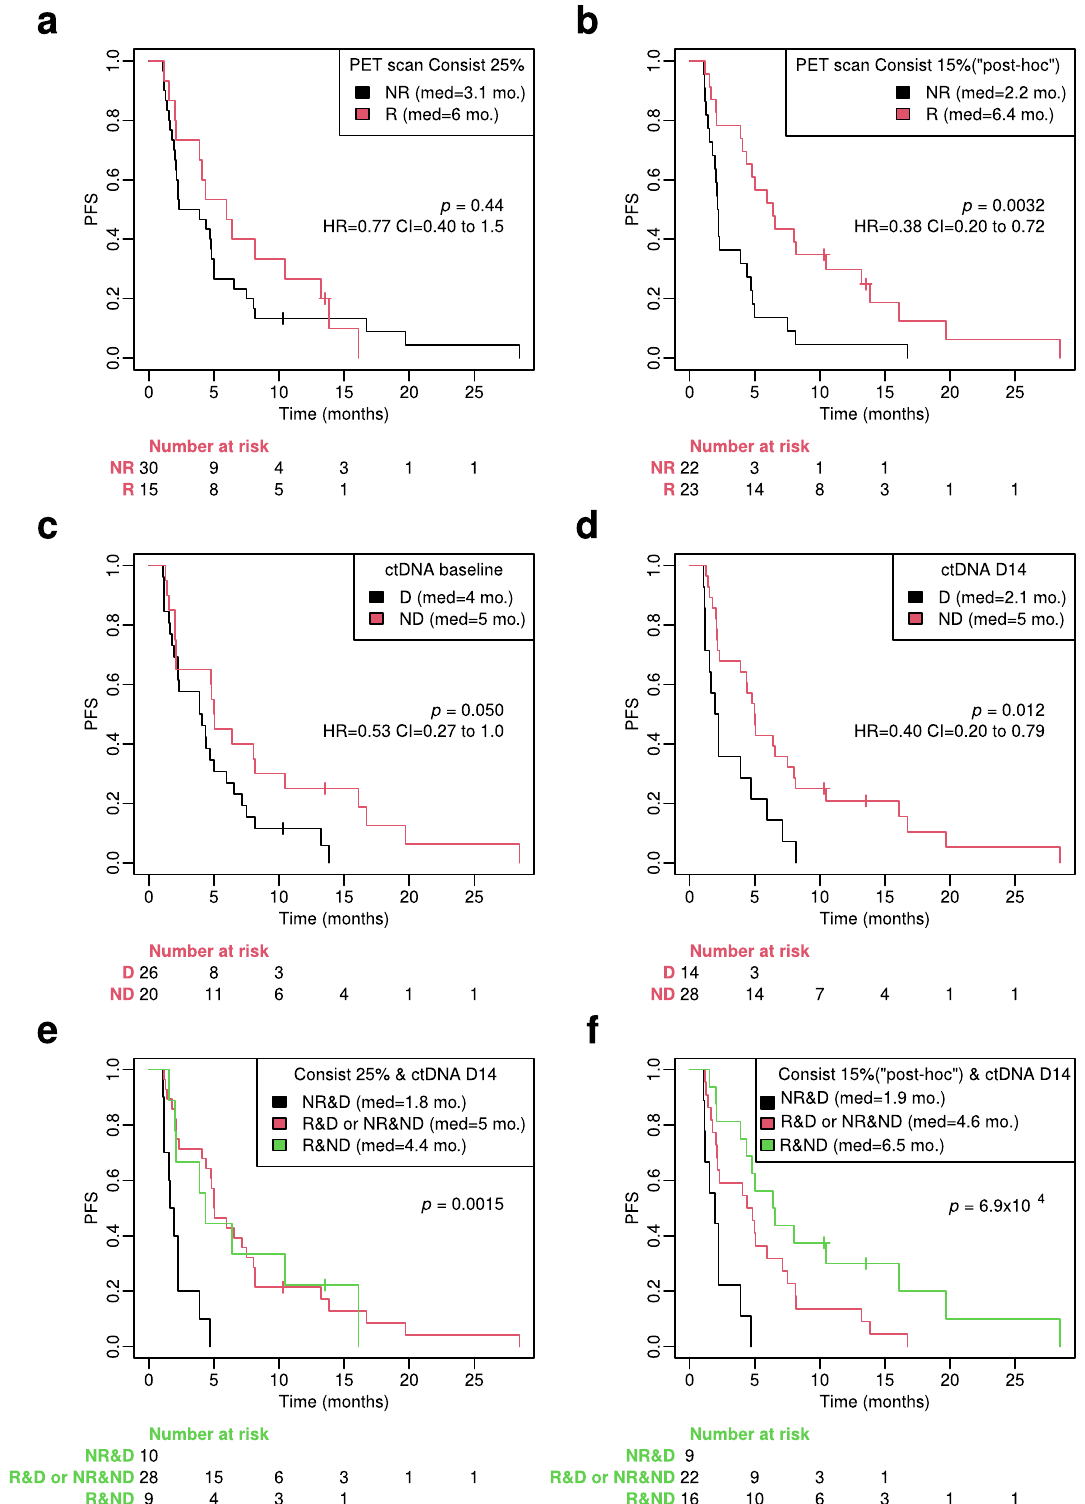
(Supplementary Fig. 2). As initially de fi ned in the protocol, 18 F- FDG-PET/CT response was also assessed by PERCIST criteria. The prognostic value of early PET response according to this criterion is shown in Supplementary Fig. 3b,